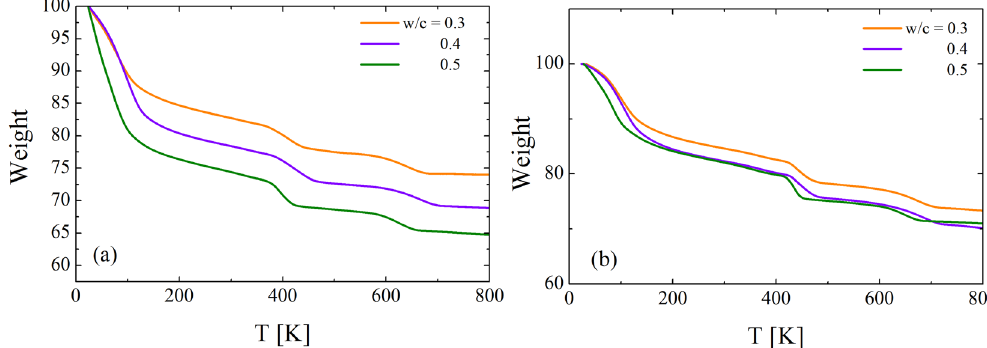
Figure 1. Thermogravimetric curves for different water-to-cement ratio ( w / c ) as indicated in the figure for samples after three weeks ( a ) and four years ( b ) of preparation.